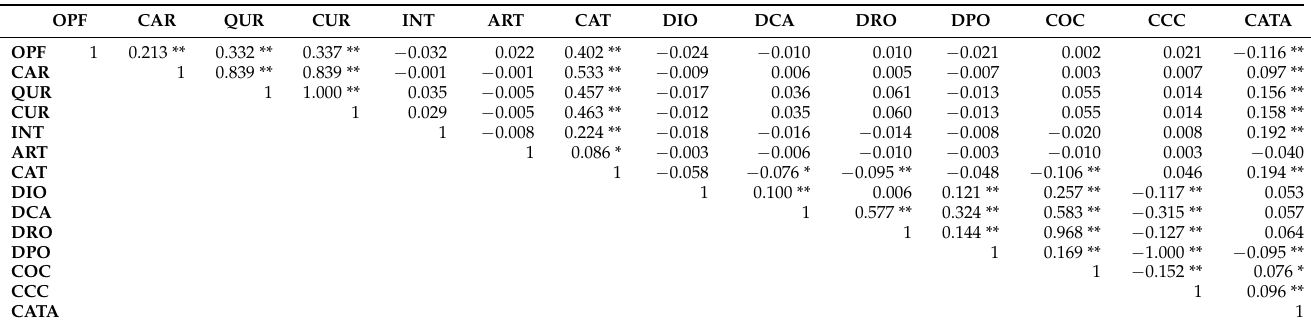
Table 6. Correlation matrix of the financial variables for the Slovak